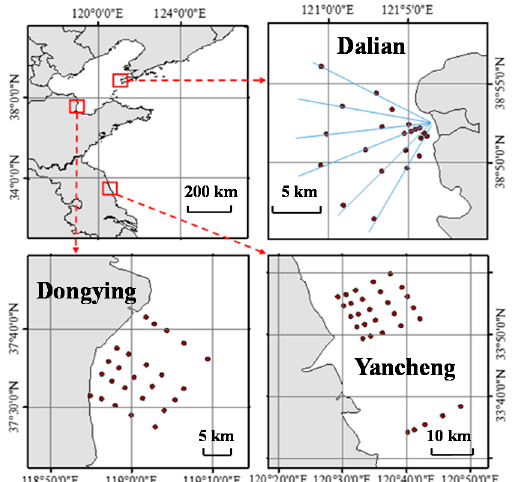
Figure 2. Sampling sites of coastal waters for detection of antibiotics.